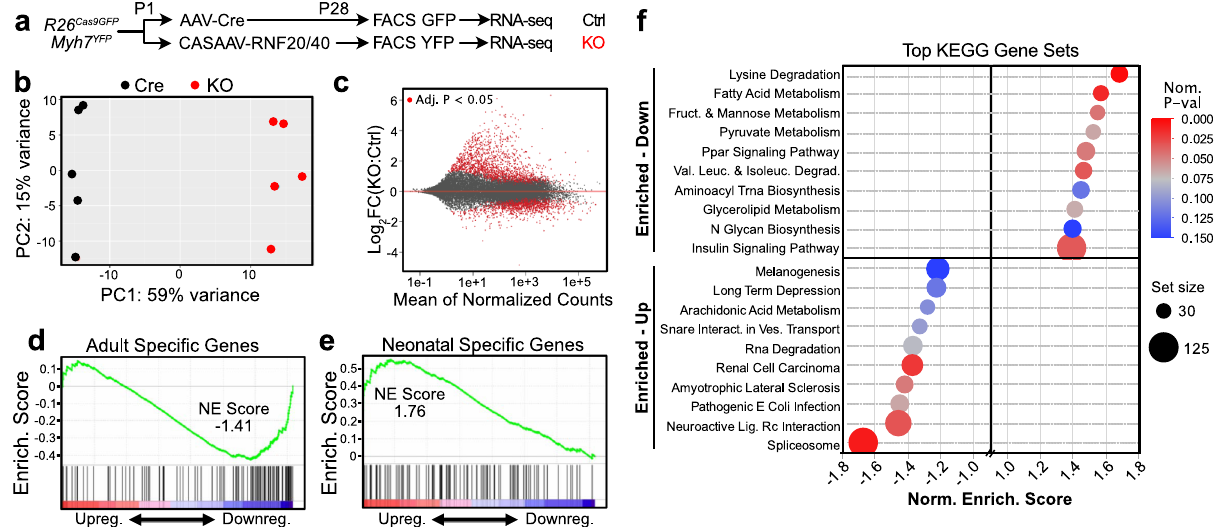
Fig. 4 Transcriptional pro fi ling of mosaic RNF20/40 -depleted CMs. a Experiment overview. b Principal component analysis of RNA-seq replicates. c Differentially expressed genes. Red indicates Benjamini – Hochberg-corrected Wald test P < 0.05. d , e Gene set enrichment analysis with custom gene sets for “ Adult Speci fi c Genes ” ( d ) or “ Neonatal Speci fi c Genes ” ( e ). RNF20/40-depleted cells were depleted for adult-speci fi c genes and enriched for adult- speci fi c genes. f Gene set enrichment analysis of indicated KEGG pathway gene sets, using genes ranked by their expression in RNF20/40-depleted CMs compared with control CMs. GSEA nominal P-val is not corrected for set size or multiple-hypothesis testing, the Normalized Enrichment Score. Source data are provided as a Source Data fi